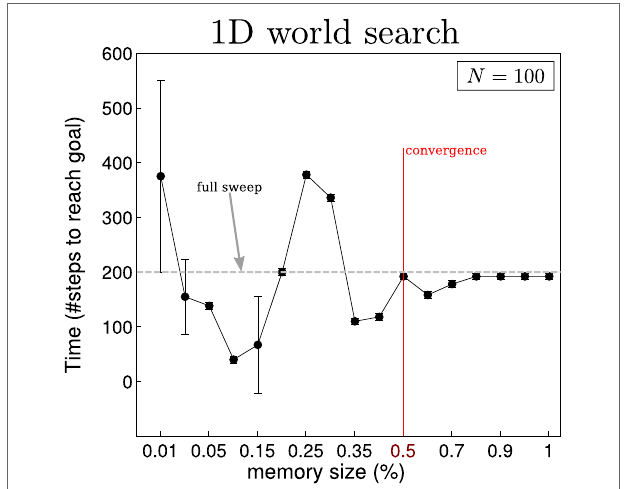
FIGURE 14 | Memory size vs time to find object in 1D. Results of the effect of the memory size on the decision process for the 1D search illustrated in Figure 13F . The memory size is reported as the percentage of total number of states present in the marginal space. At 100%, the size of the memory is equal to that of the state space, N = 100 in this case. A total sweep of the entire state space would result in a total of 200 steps, the dotted gray line in the figure. When no restrictions are placed on the memory size, the policy following the greedy approach takes around 180 steps. This result converges when the number of parameters | (cid:9) 0: t | of the memory likelihood function is greater than 50% of the original state